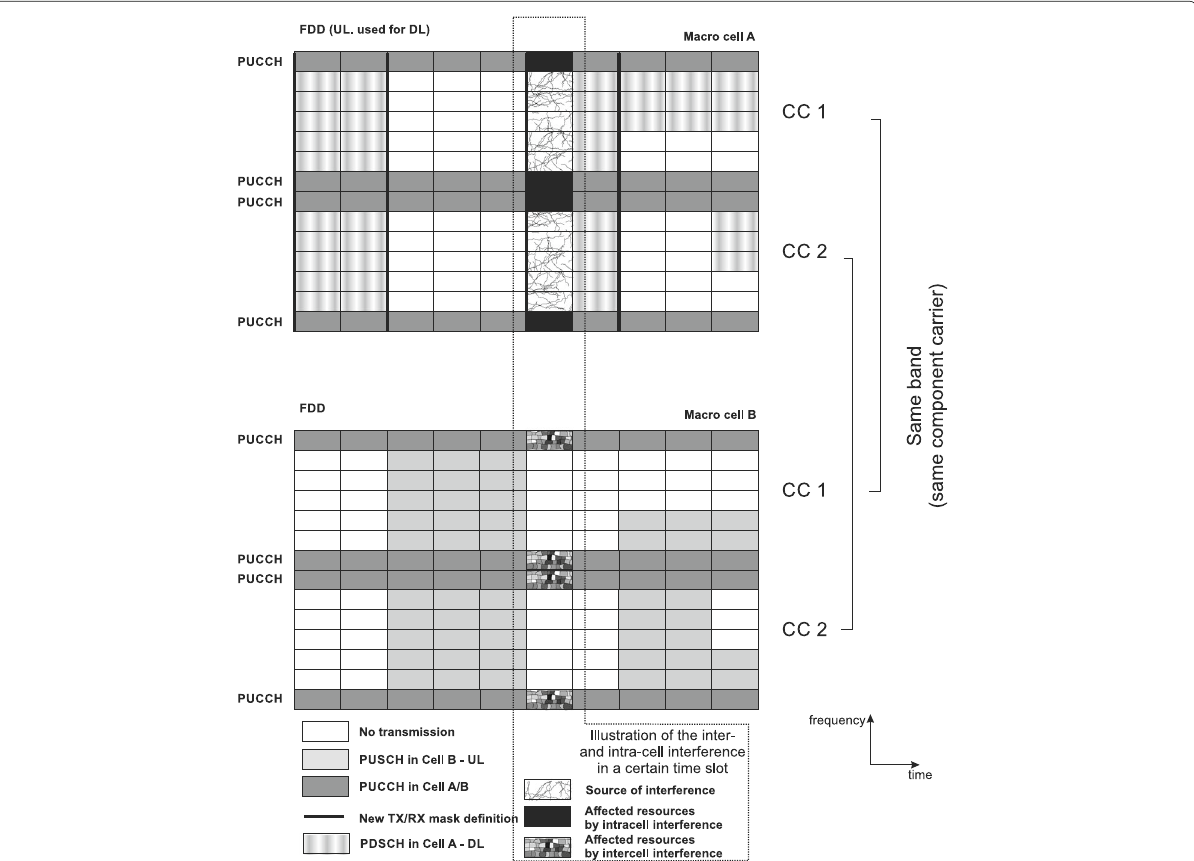
Fig. 5 Proposed scheme for simultaneous flexible duplexing—multichannel